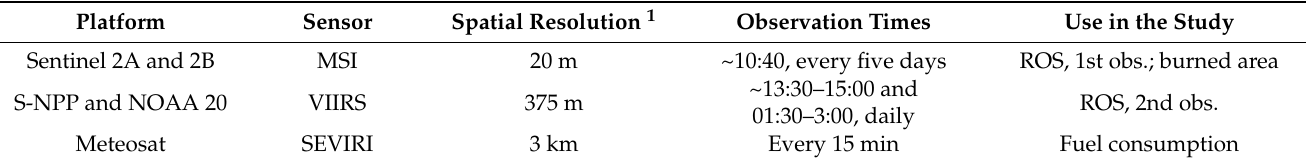
Table 1. Overview of satellite sensors used in this